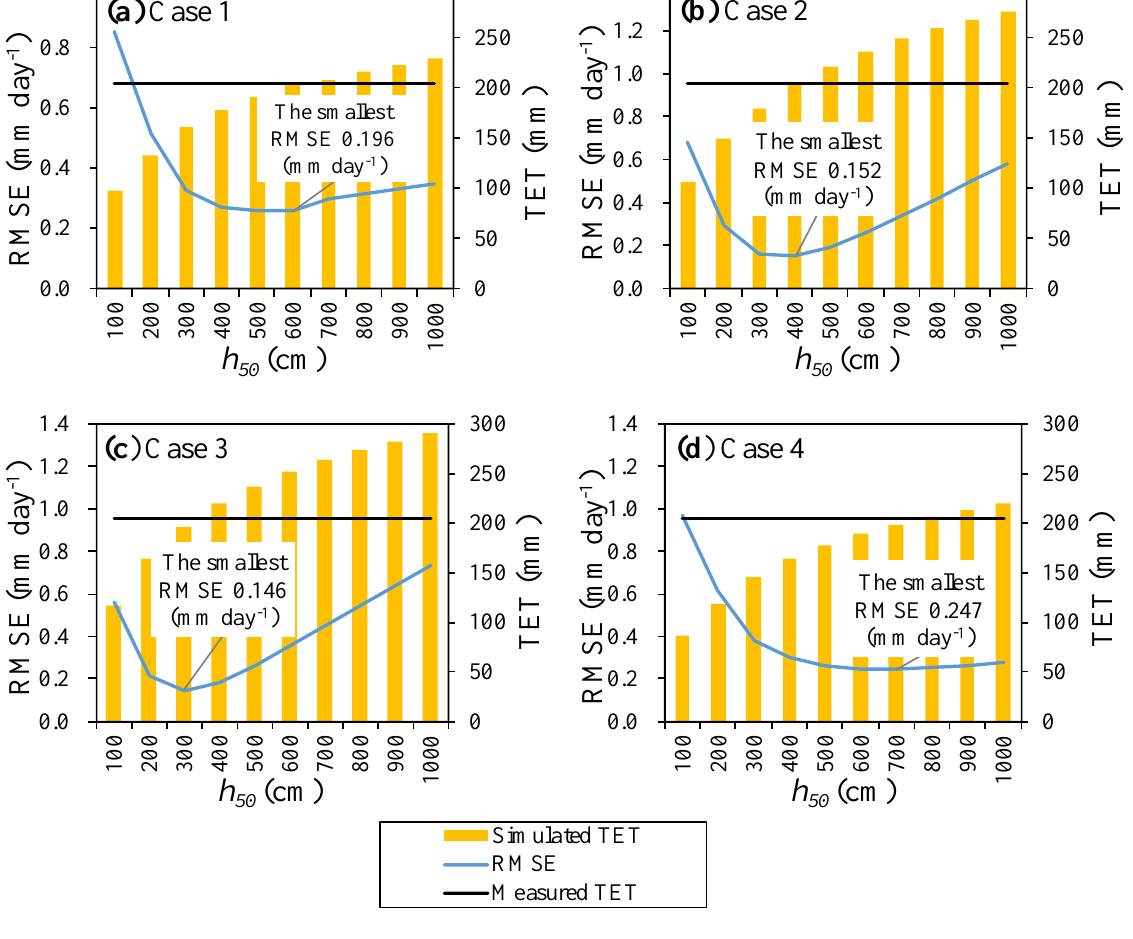
to RMSE and TET for each Case. ( a ) Case1; 50